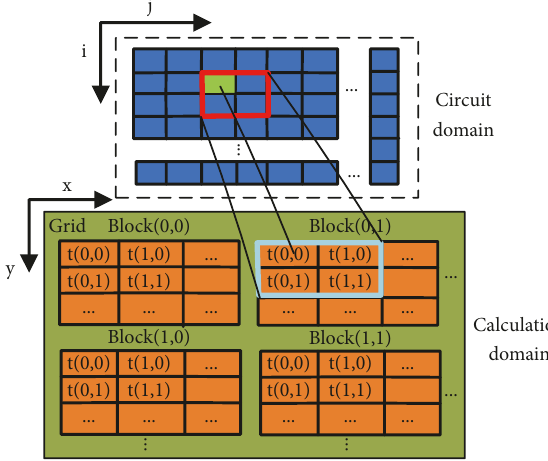
Figure 5: Mapping between real domain and CUDA grid of thread blocks.